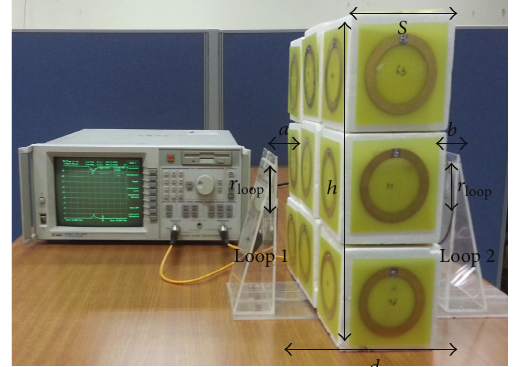
Figure 4: Measurement setup for two loop WPT system using a = 5.5, 𝑟 = 0.1, 𝑑 = 24, 𝑠 = 12, ℎ = 36, and 𝑎 metamaterial slab ( 𝑟 loop ring = 𝑏 = 6 (unit: cm)).